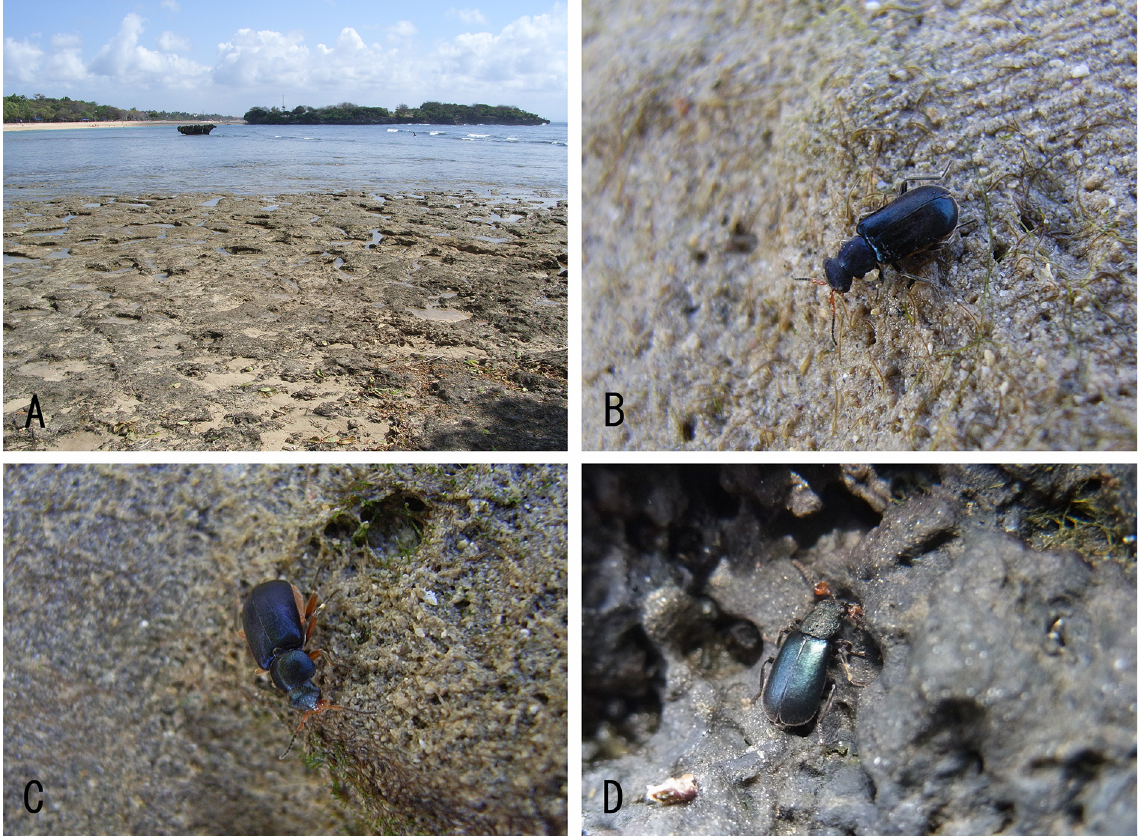
Fig. 13. Habitat and habits of Laius spp. A . Type locality (Nusa Dua, Bali, Indonesia) of Laius baliensis sp. nov. and L. satoi Yoshitomi, 2008, three Laius species living sympatrically. B . L. baliensis sp. nov., female. C . L. satoi , male. D . L. asahinai Nakane, 1955 (at Miyake-jima). Photographs by